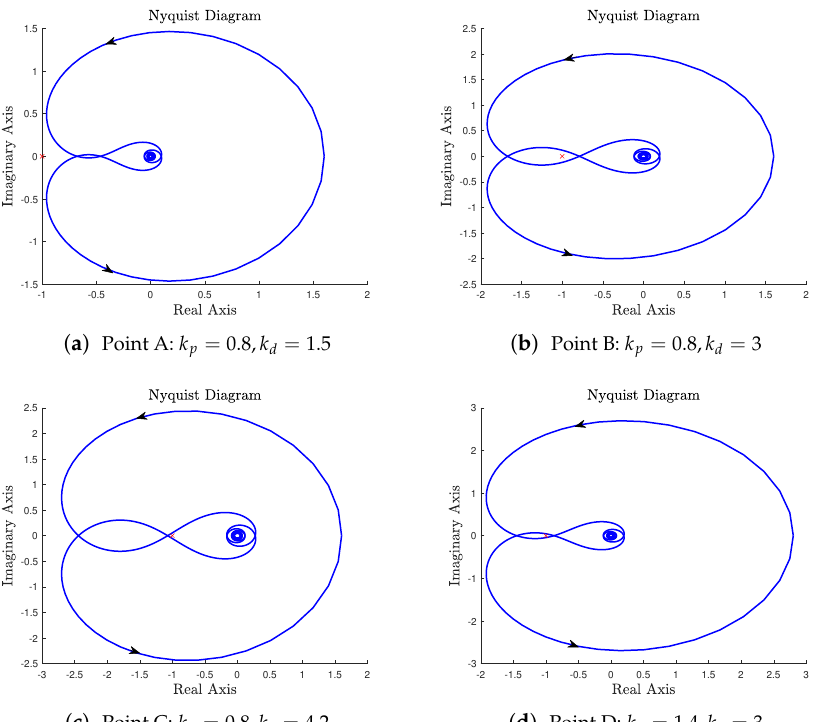
Figure 6. Nyquist curves of the plant (Equation (45)) for different PD parameters. Next, the ways in which the time delay may affect the feasible PD parameter region will be discussed. Let us reduce time delay τ to 0.1. Figure 7 shows that the region will be expanded with respect to the case of τ = 0.3 (Figure 5b).